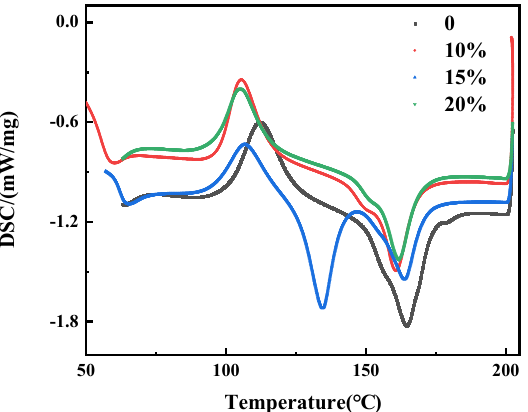
Figure 8. DSC curves of TPU/PLA composites with different flame-retardant contents. Table 2. DSC data of melt crystallization of TPU/PLA composites with different flame-retardant